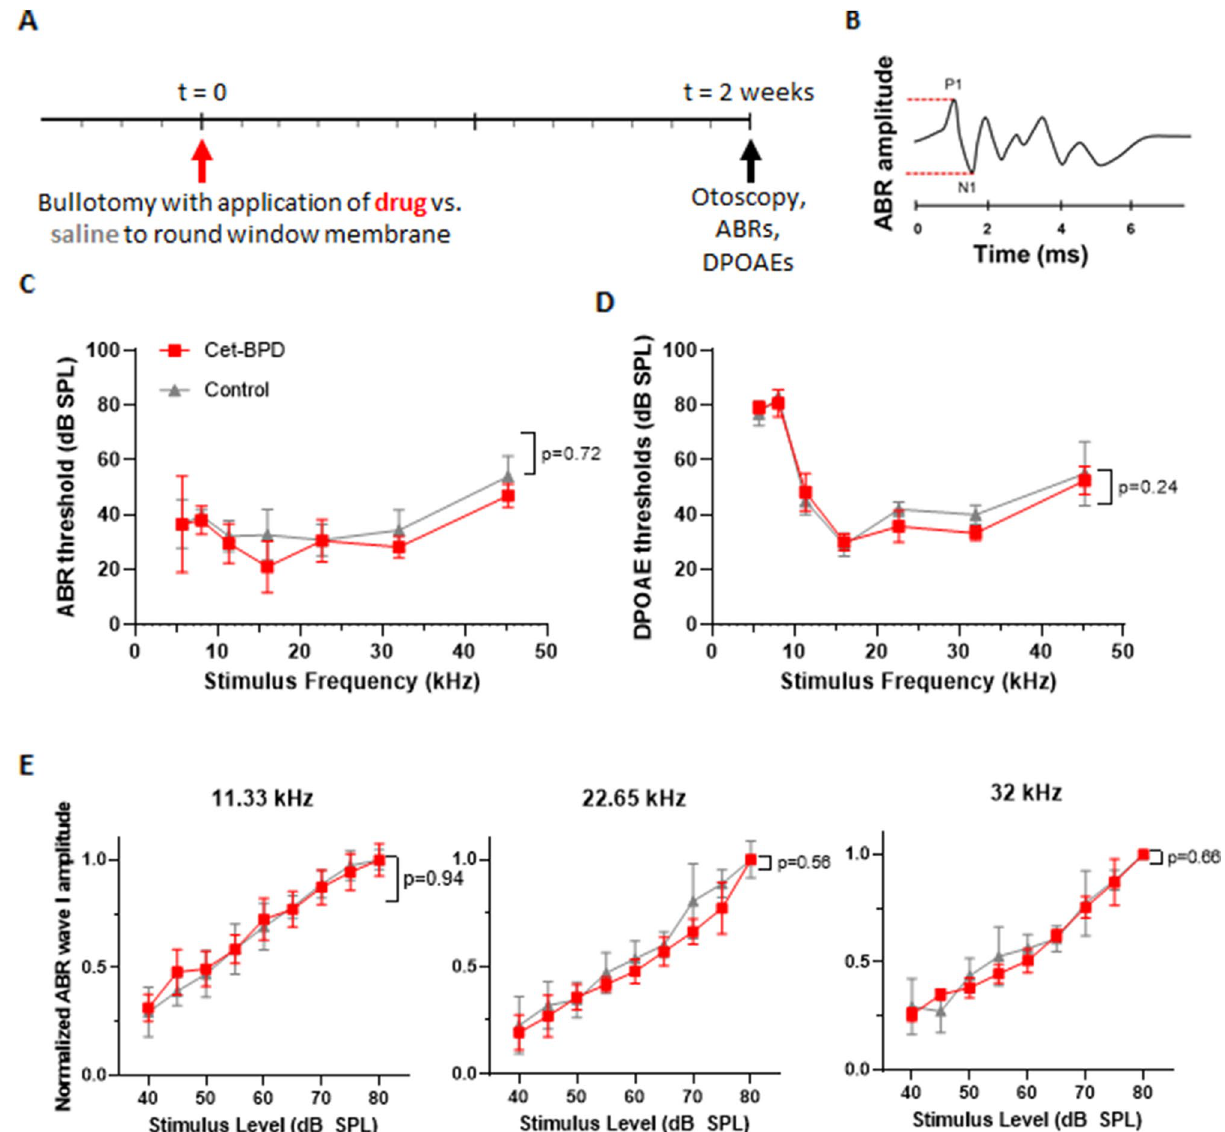
Figure 2. Cet-BPD PIC is not ototoxic. ( A ) Schematic timeline of the experimental protocol. ( B ) Schematic of ABR waveform; ABR wave I amplitude is measured between P1 and N1. ( C ) ABR thresholds and ( D ) DPOAE thresholds are plotted as a function of frequency for Cet-BPD group (red, N = 6 mice) and control group that received phosphate-buffered saline (gray; N = 5 mice). Data are represented as means + SEM. ( E ) ABR wave I amplitude, normalized to the amplitude of ABR wave I at 80 dB in the same animal, is plotted as a function of stimulus level for three representative frequencies for Cet-BPD group (red, N = 6 mice) and control group that received phosphate-buffered saline (gray; N = 5 mice). Data are represented as means +